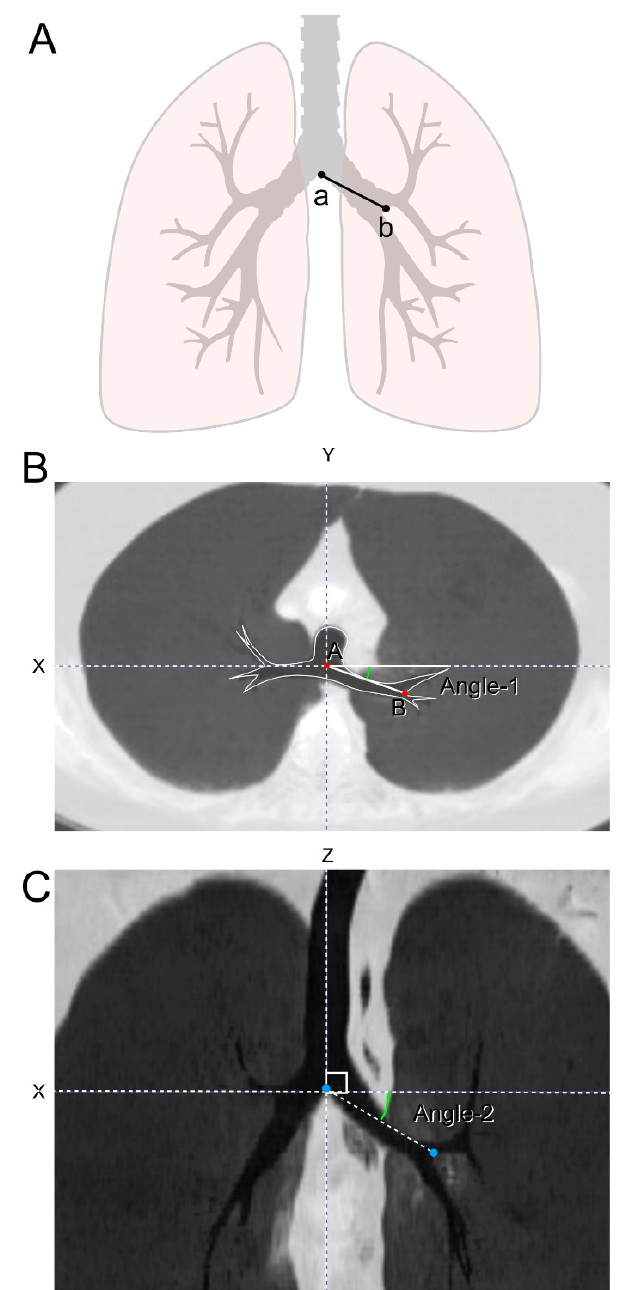
Figure 3. Measurement of bronchial angles. ( A ) The angulation of left main bronchus was